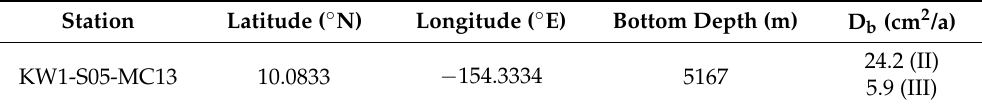
Figure 1. Sampling locations. Table 1. Coordinates of sampling stations and bioturbation coefficients. Table 1. Coordinates of sampling stations and bioturbation